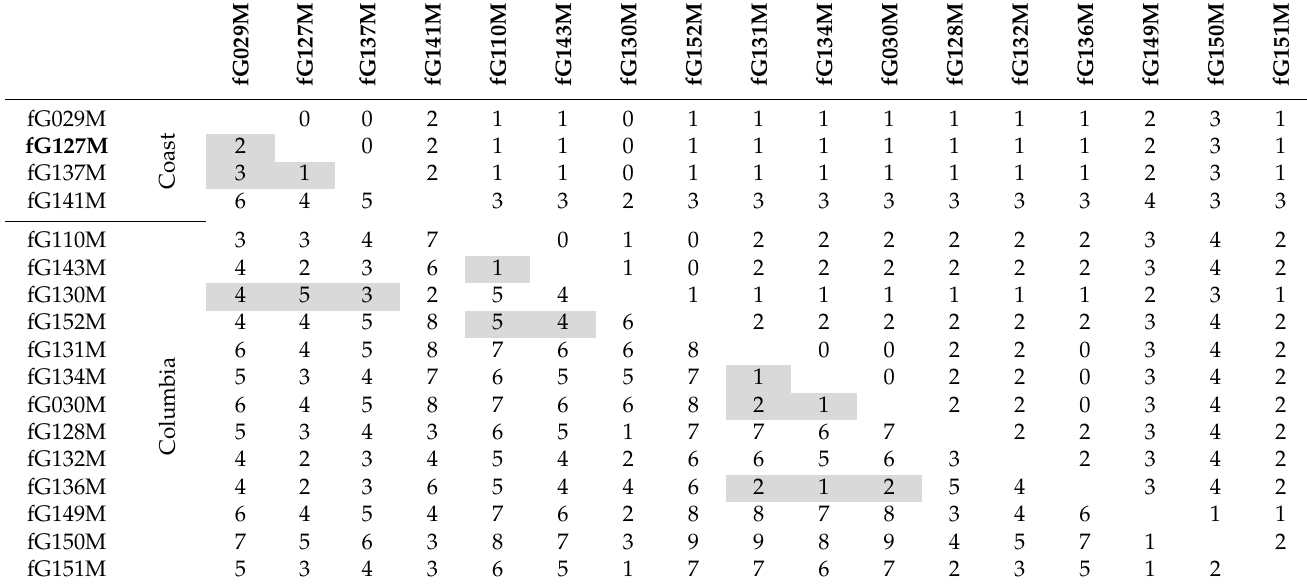
Table 3. Pairwise comparisons of all fullG type sequences found among second emergence mG110M isolates. Nucleotide differences are on the lower half of the matrix, and amino acids are in the upper half. Genotypes are listed according to which coast or Columbia region they were detected in, except for bold text genotypes, which occurred in both. Cells highlighted in grey indicate nucleotide differences that are silent. Genotype fG129M was excluded due to short sequence,